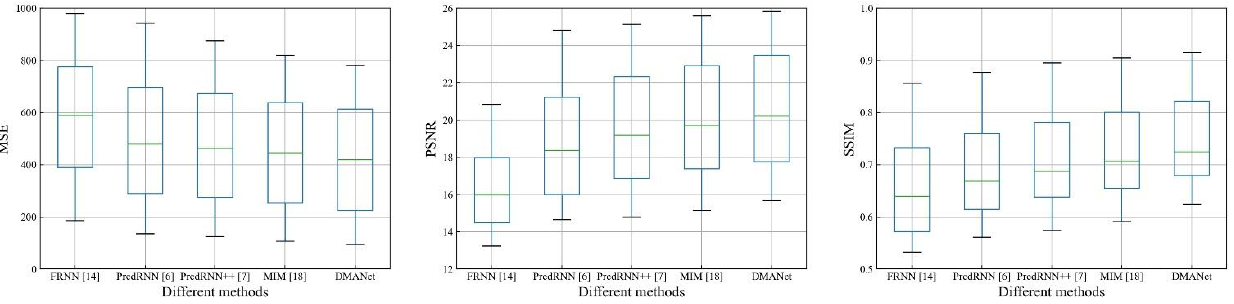
Figure 12. Whisker plot comparisons of the different models at the Caltech [36].